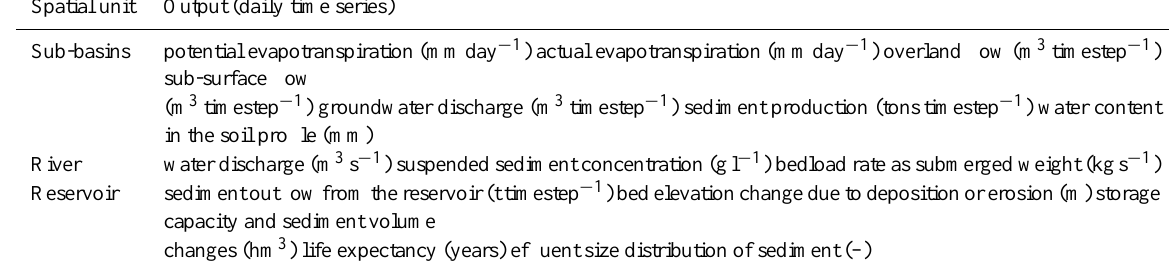
Table 4. Model output files of WASA-SED. Spatial unit